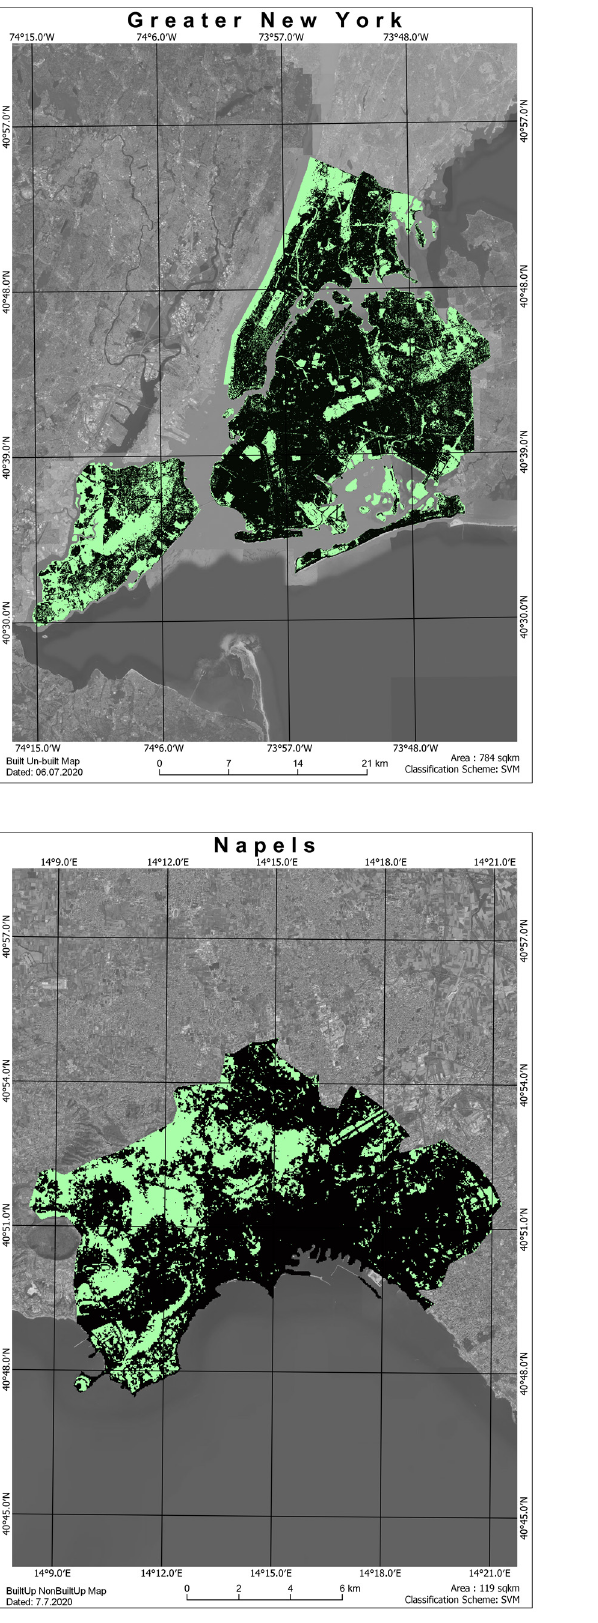
Figure 5. Built (black)/unbuilt (green) map with a corresponding heat map for both a megacity and its respective mid-sized city in a high-latitude region (New York and Naples).